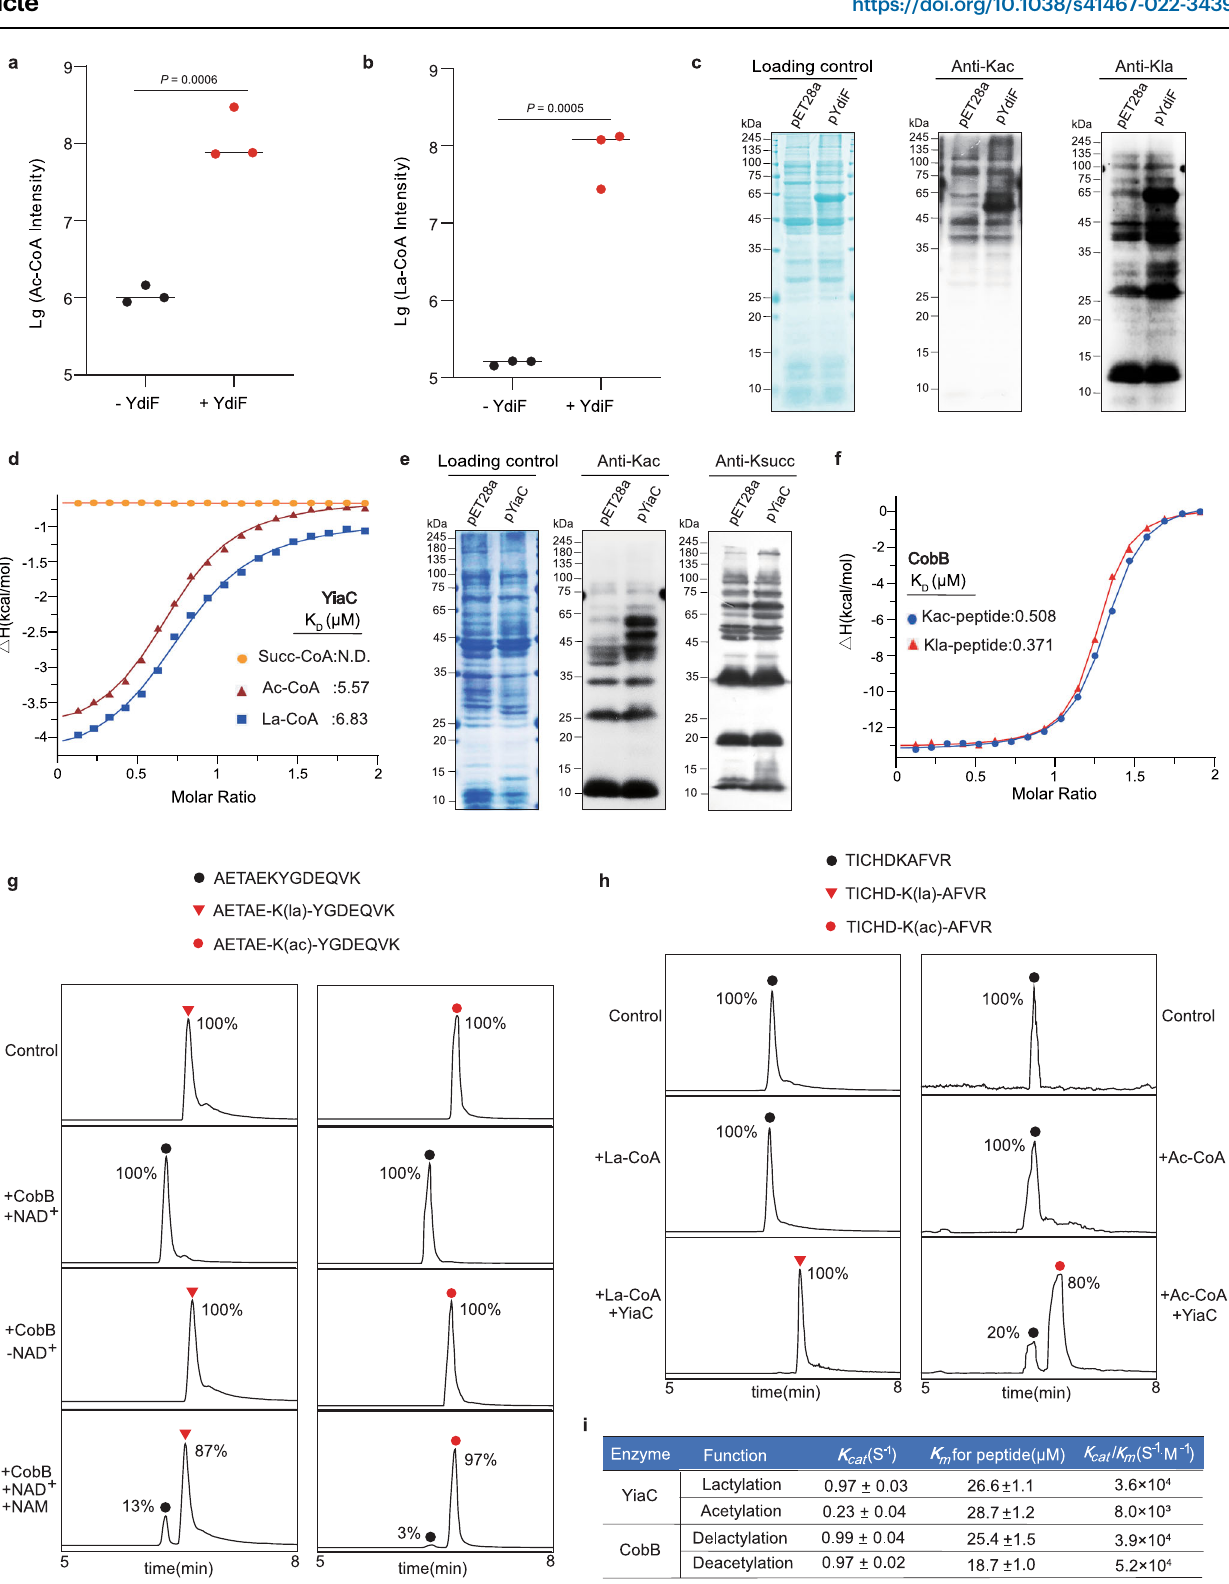
delactylation. The kinetic measurements (Fig. 2i, Supplementary Fig. 3, Supplementary Data 2) con fi rmed the lactylase activity of YiaC ( k cat = 0.97 ± 0.03 s − 1 , K m = 26.6 ± 1.1 μ M, k cat / K m = 3.6 × 10 4 s − 1. M − 1 ) is more effective than acetylase ( k cat = 0.23 ± 0.04 s − 1 , K m = 28.7 ± 1.2 μ M, k cat / K m = 8.0 × 10 3 s − 1. M − 1 ). The delactylase